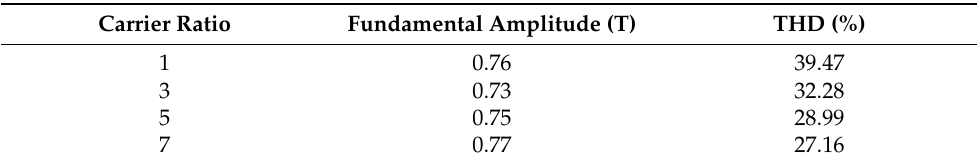
Table 2. Comparison of fundamental wave amplitude and harmonic distortion rate of air-gap magnetic density.